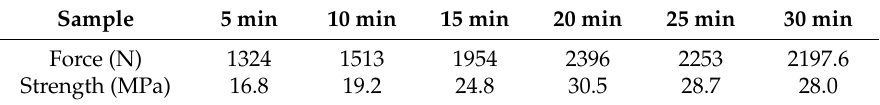
Figure 11. Load vs extension for the shear test of the 5-, 20-, and 30-min bonds. Table 4. Maximum load and shear strength of the bonds made at different bonding times.